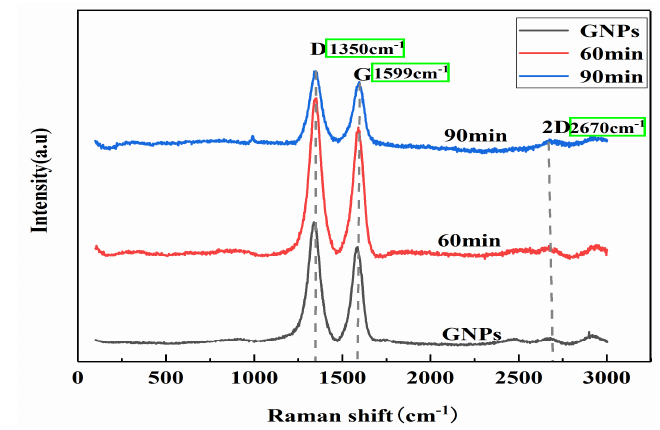
Figure 5. Raman spectra of graphene before and after ultrasonication.